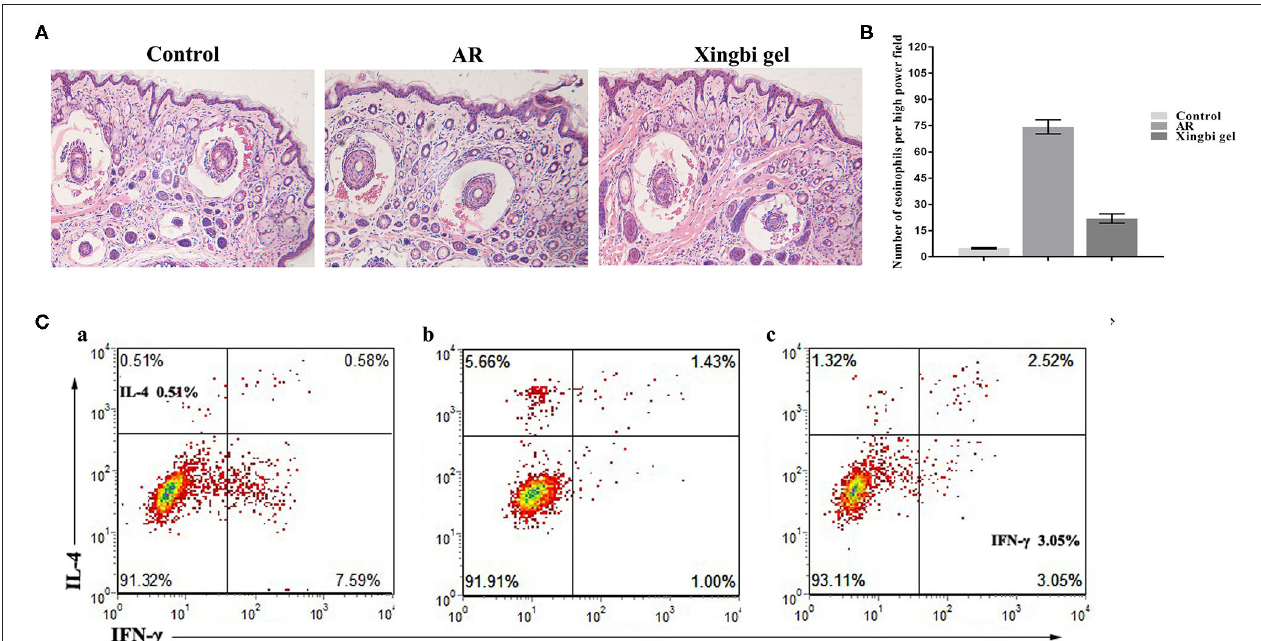
FIGURE 2 | Effects of Xingbi gel on AR mouse model. (A) Effect of Xingnin gel on pathological changes. (B) Eosinophils histogram. (C) Changes in the percentage of Th1 and Th2 expression in CD4 + T cells detected by flow cytometry. (a) The percentage of IL-4 and IFN- γ in the normal group. (b) The percentage of IL-4, IFN- γ and TH1/TH2 in the AR model group was increased, decreased, and the percentage of TH1/TH2 was unbalanced compared with the normal group. (c) Compared with the AR model group, the percentage of IL-4 and IFN- γ were decreased and increased after Xingbi gel